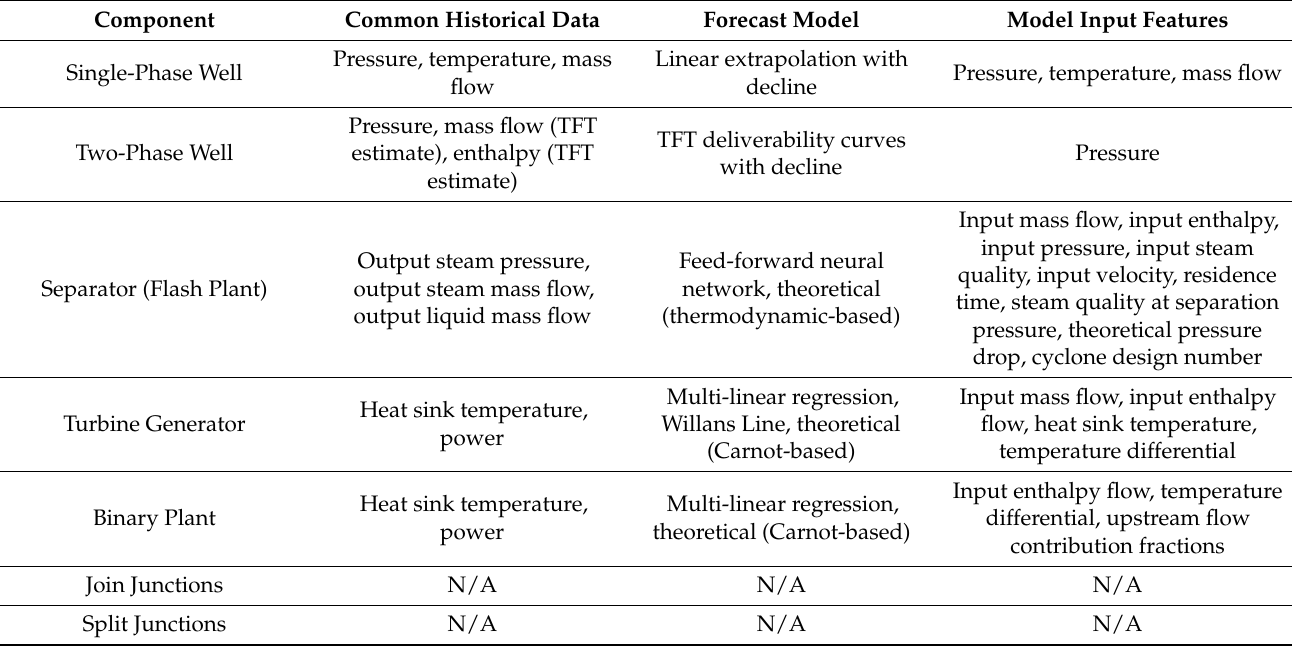
Table 1. Basic GOOML component model